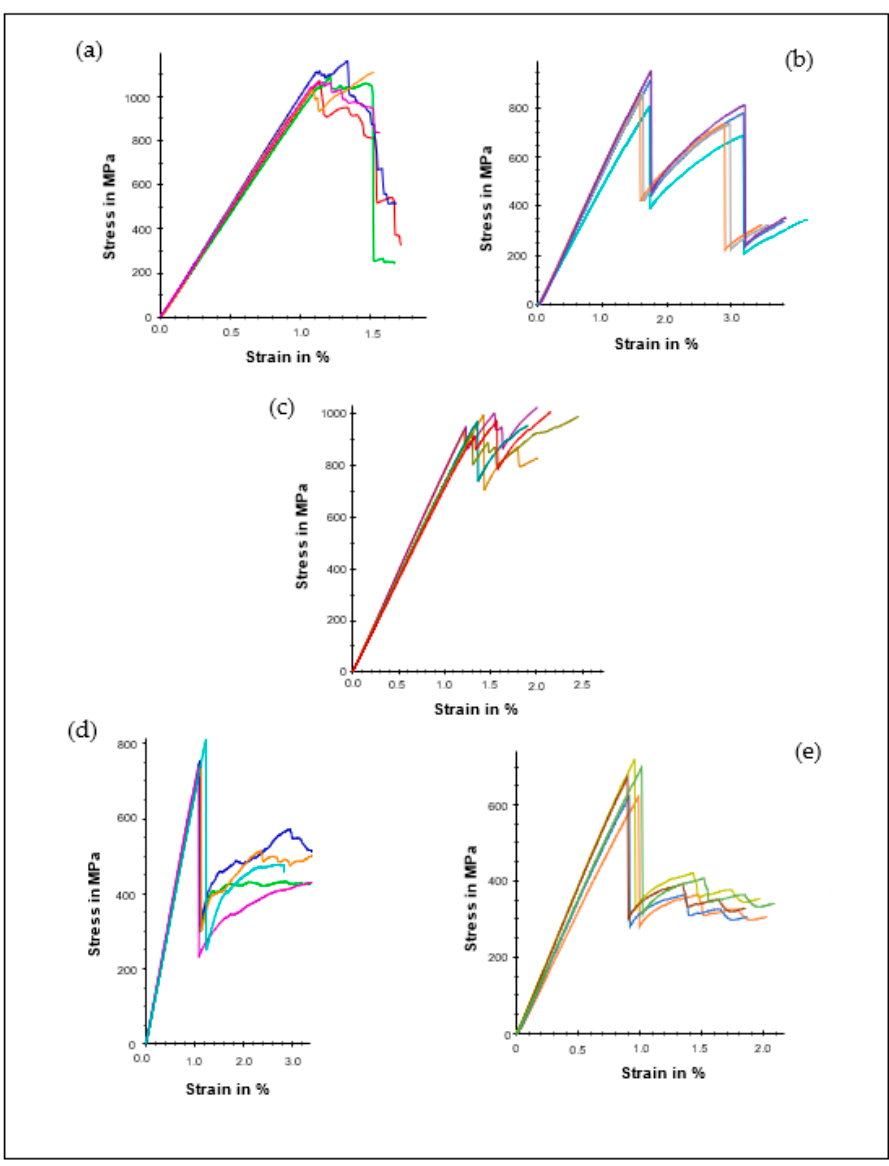
Figure 3. Flexural stress and deformation curves for ( a ) LM1, ( b ) LM2, ( c ) LM3, ( d ) LM4, ( e ) LM5. As shown in Table 3, (cid:2026) and (cid:1831) of LM3 increase by 17.9% and 59.5%, (cid:3033) (cid:3033)